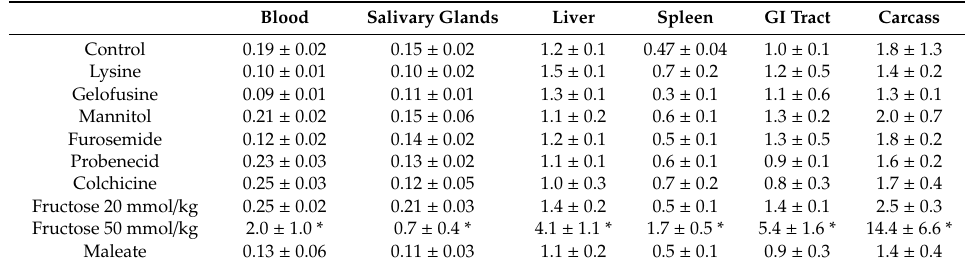
Table 1. Biodistribution of [ 99m Tc]Tc(CO) 3 -ADAPT6 in NMRI mice 4 h p.i. administered alone (control) or after treatment with the compounds.